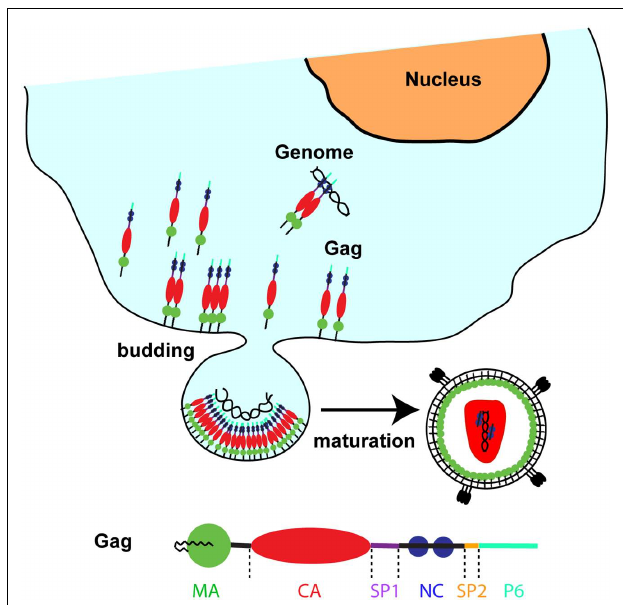
FIGURE 1 | Schematic representation showing the late phase of HIV replication involving Gag targeting and assembly on the plasma